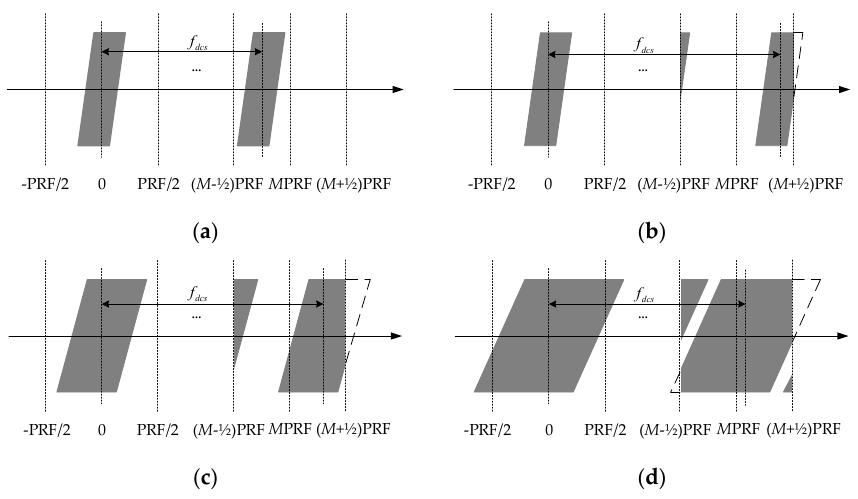
Figure 4. Theoretical azimuth spectrum distributions: ( a ) spectrum entirely in a PRF band; ( b ) spectrum spanning neighbouring PRF; ( c ) Doppler bandwidth exceeding PRF/2; and ( d ) Doppler bandwidth exceeding the PRF.